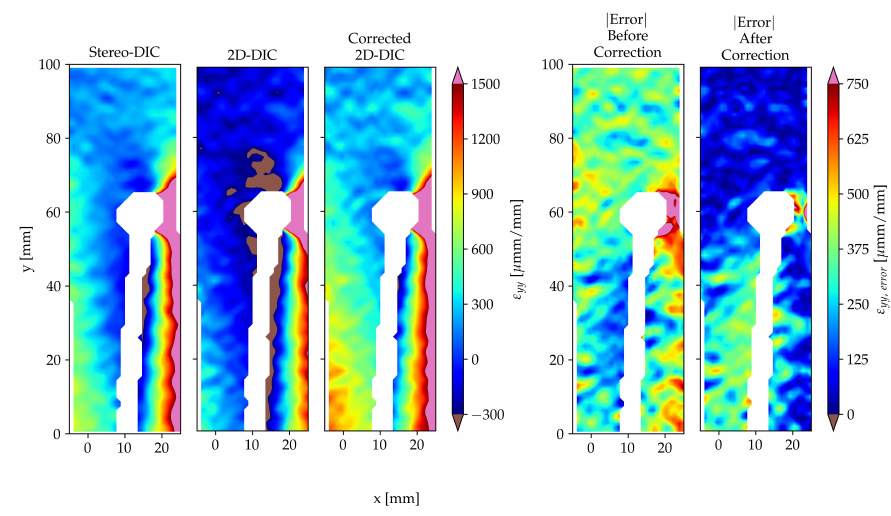
Figure 12. Contour plots of the stereo-DIC, 2D-DIC, corrected 2D-DIC and error data for the 700th image of Test 2.